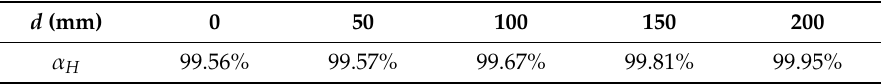
Table 3. Comparison of the horizontal stability of the inner receiver coil.